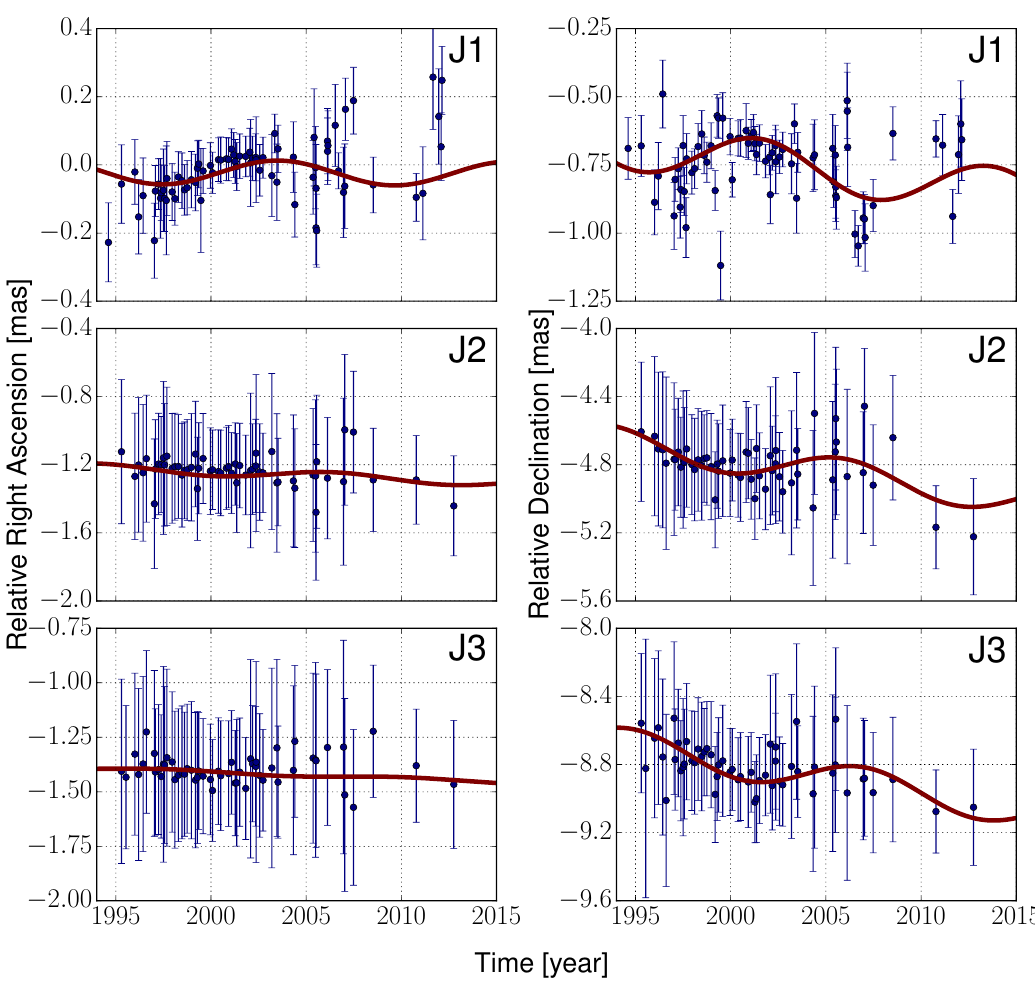
Figure 3. The relative separation of the components from the core as a function of time, and the best-fitting model (solid curves). Not all components were detected at each epoch, and the dense time sampling allowed us to drop out positional outliers over 3 σ from the analysis. As a result, the fitted precession model is based on 73, 56, and 55 observing epochs for components J1, J2, and J3,